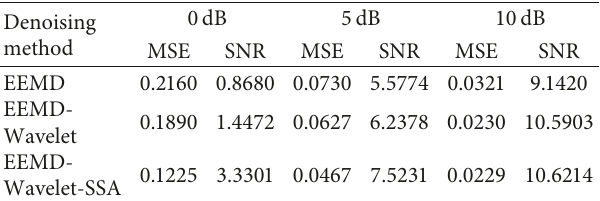
Table 1: Simulation signal denoising